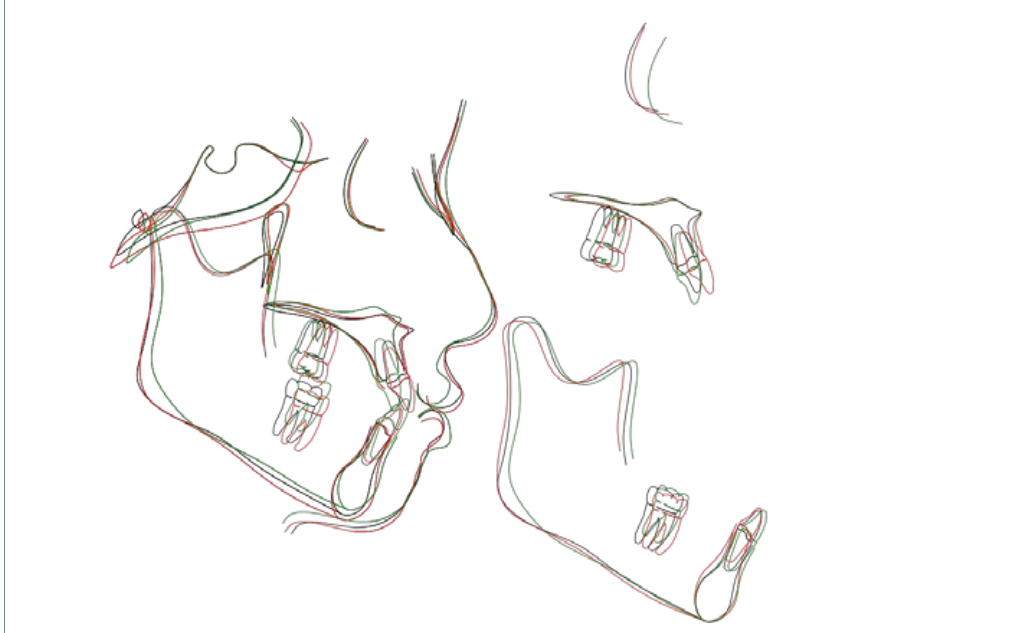
Figure 14. Superimposed tracings (green, pretreatment; black, after growth modification; red,